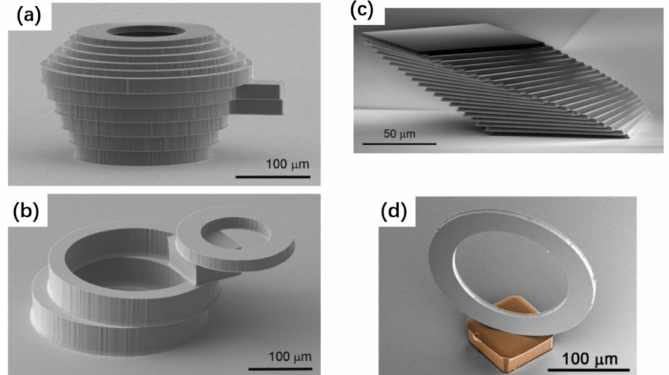
Figure 26. Examples of complex 3D objects formed by transfer printing. ( a ) Stacked silicon rings with varied thicknesses and diameters. Adapted from [266]. ( b ) A combination of silicon rings and a silicon square block. Adapted from [266]. ( c ) Multilayer configurations of 3 µ m thick silicon platelets in a single stack with small incremental rotations and translations. Adapted from [233]. ( d ) A vertically aligned Si ring joined to an SU-8 resist block. Adapted with permission from [267]. Copyright IOP Publishing, 2012.